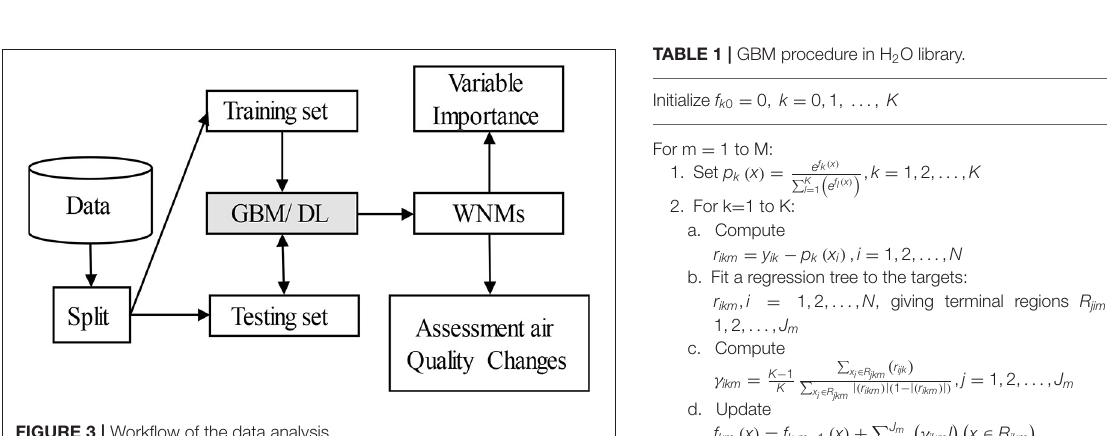
FIGURE 3 | Workflow of the data analysis.